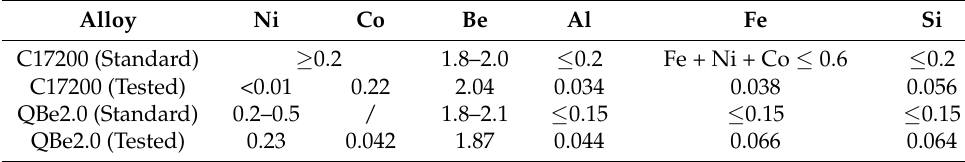
Table 1. The chemical compositions of the tested alloys, wt.%.